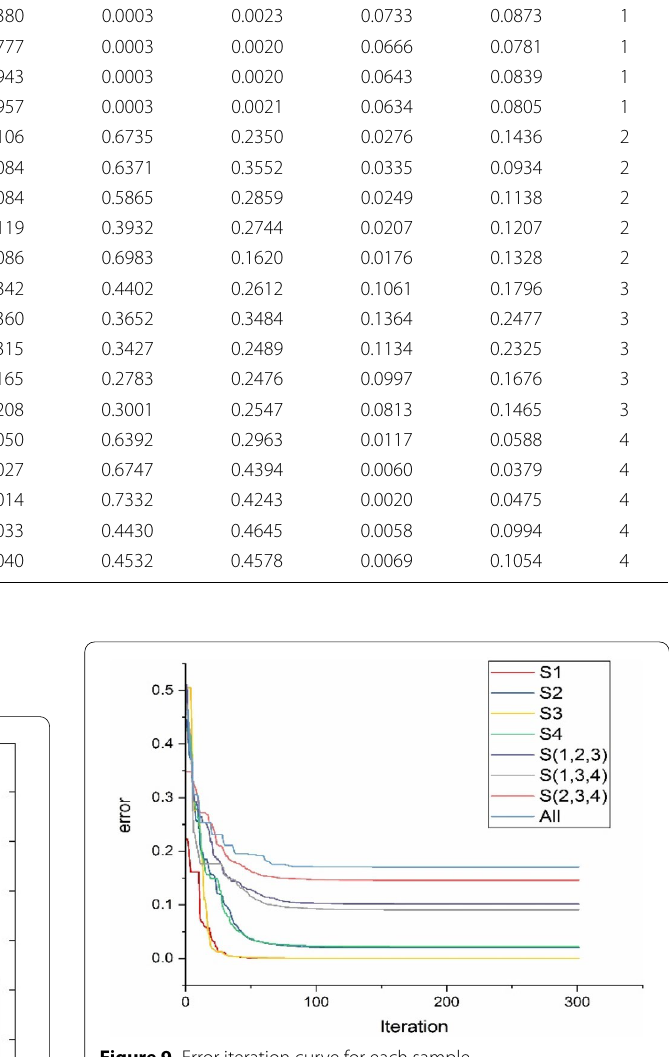
Figure 9 Error iteration curve for each